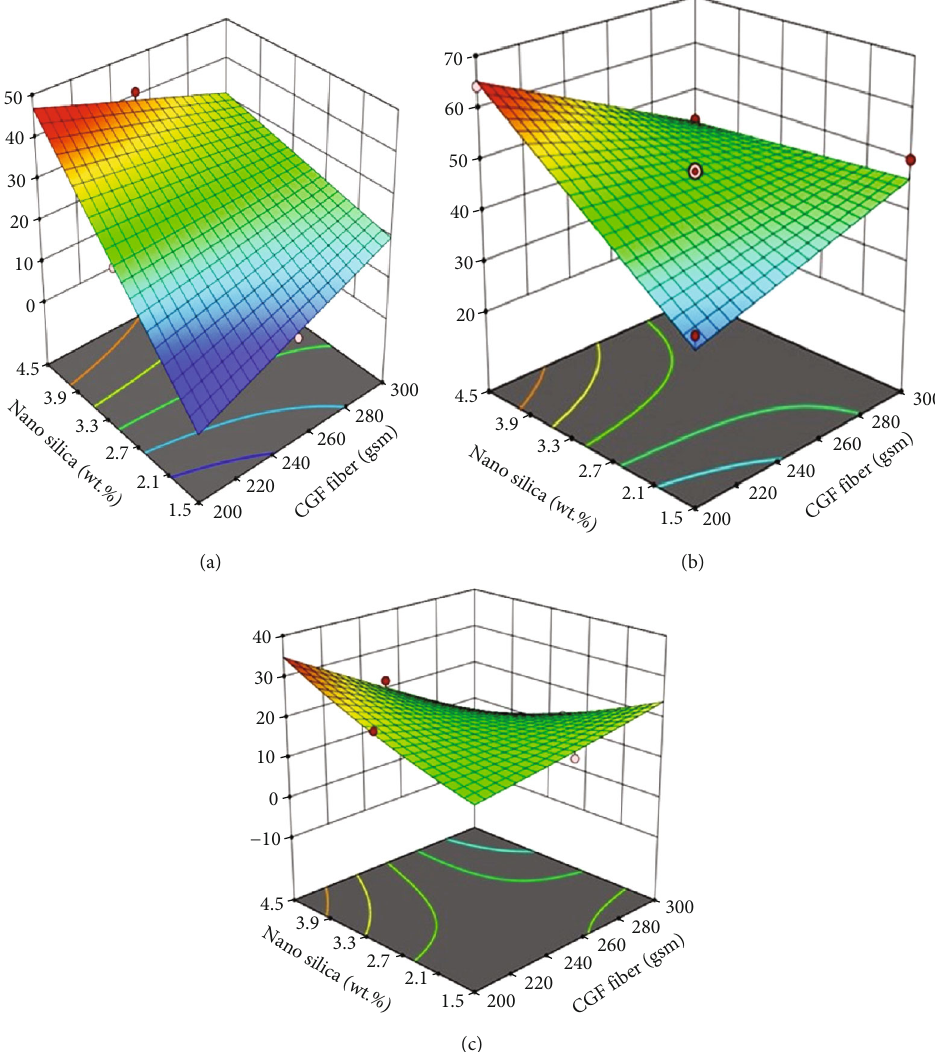
Figure 3: Surface plot of di ff erent CGF nanocomposites. (a) Tension, (b) bending, and (c) impact